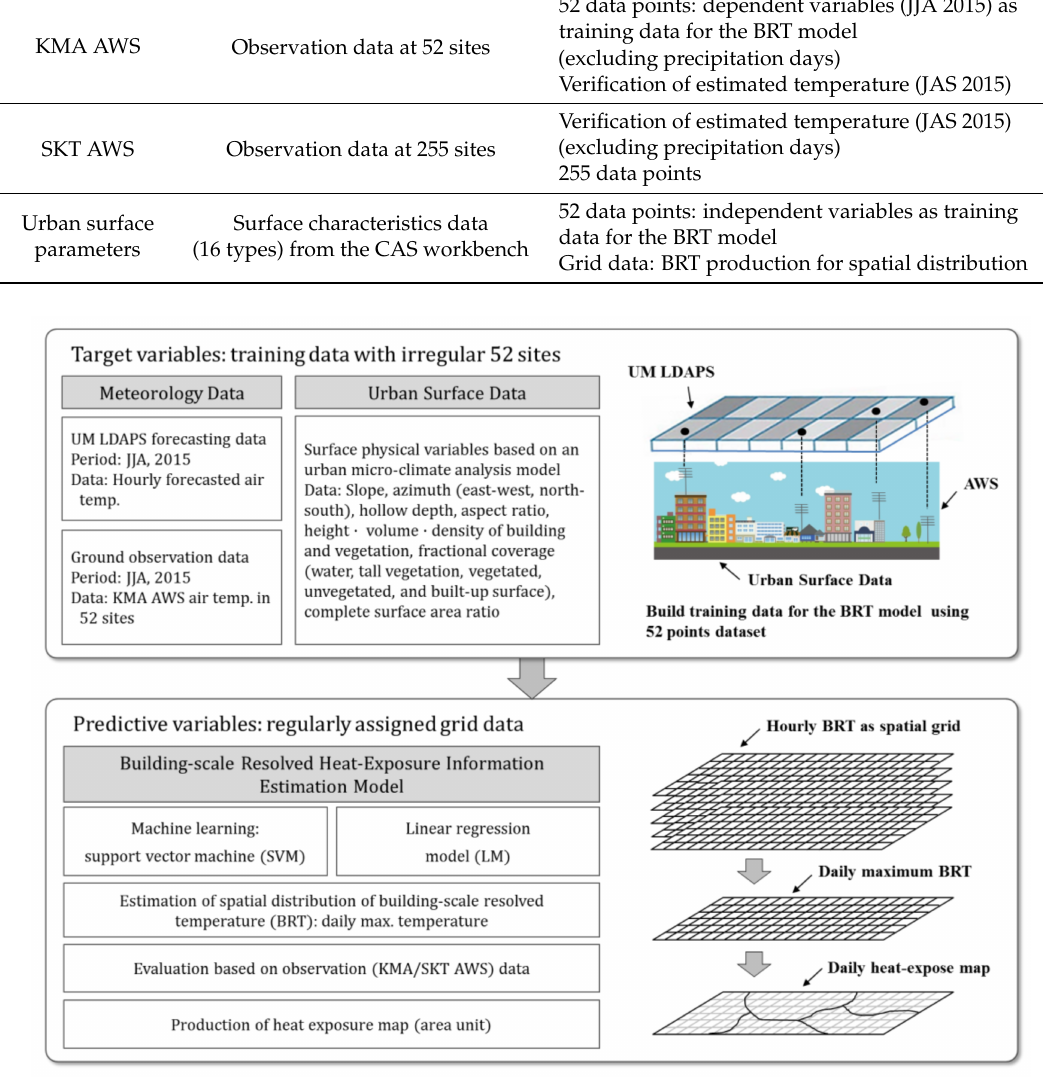
Figure 3. Flow chart of the development of the BRT